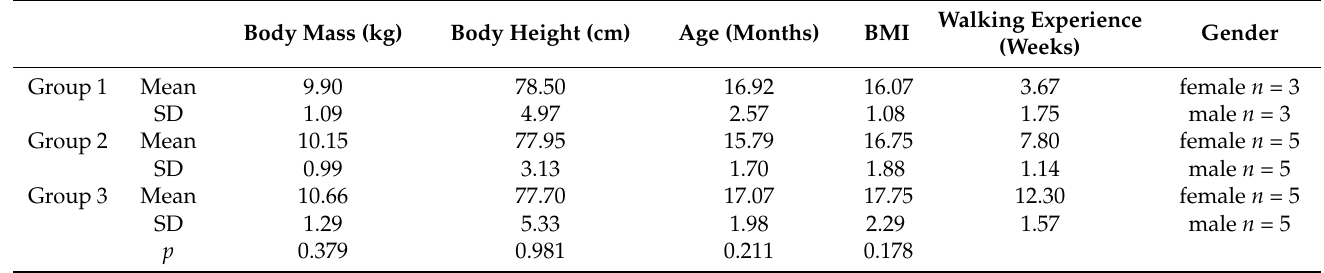
Table 1. Groups’ characteristics.